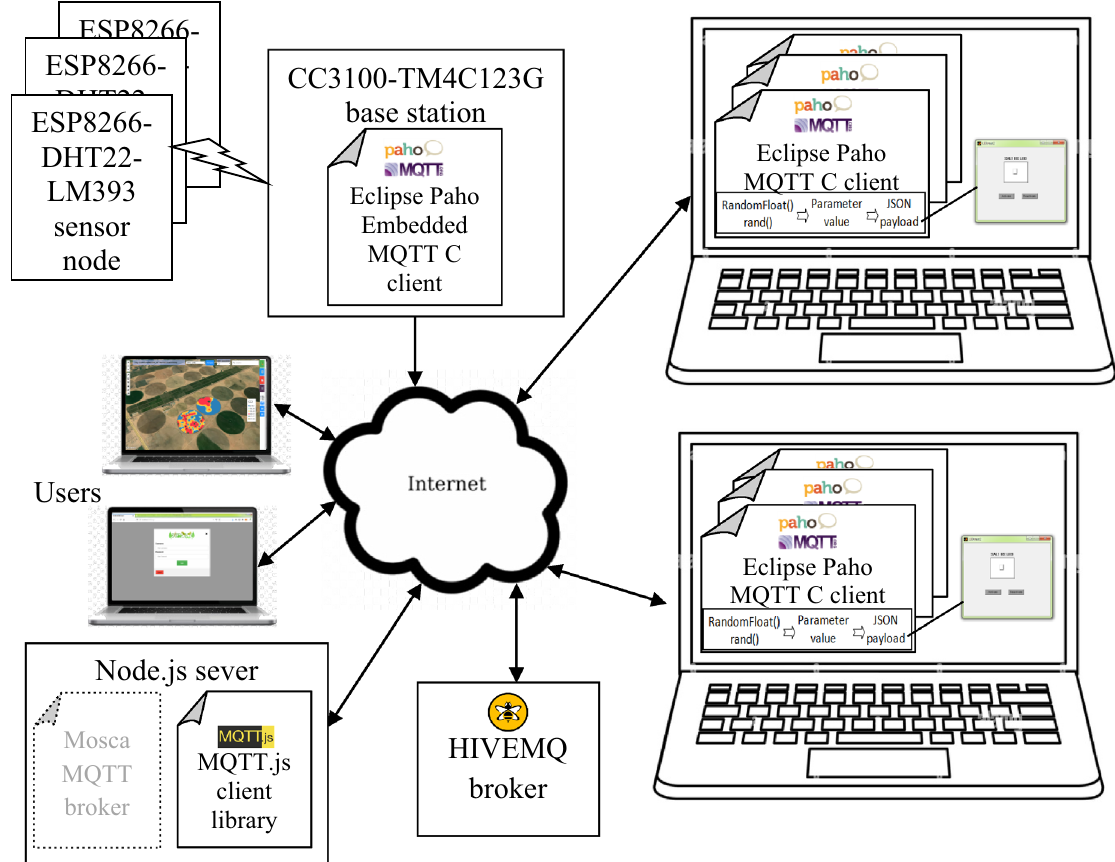
Figure 9. System validation setup block diagram.